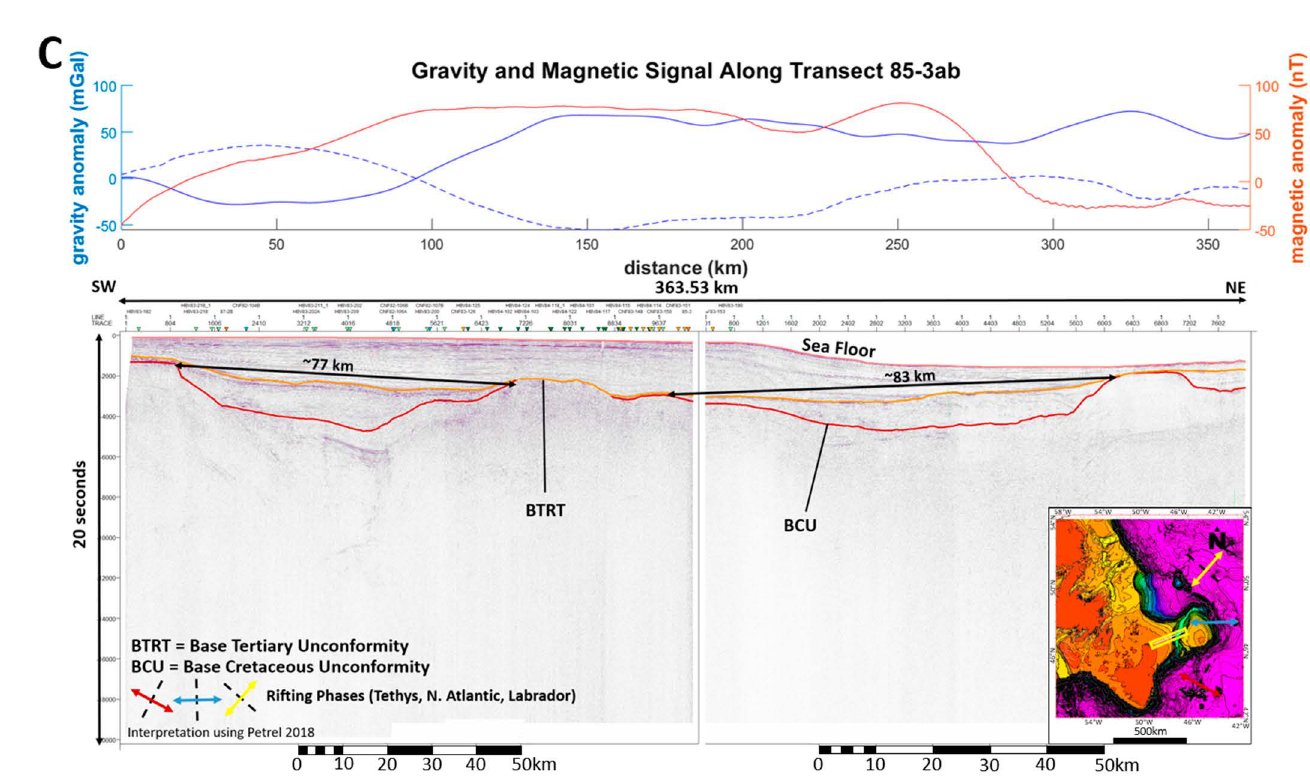
Figure 5. Interpretation of Lithoprobe line segments [54–56] and corresponding uncorrected (dashed, blue lines) and bathymetry-corrected (solid, blue lines) free air gravity, as well as magnetic anomaly (red) signatures along transects. Estimated observed boudinage wavelengths before corrections outlined in Section 3.2. Insets display location of transects within the Grand Banks region. ( A ) 87-2b, features aligned with extension related to the Tethys rifting phase (approximately 200 Ma) ( B ) 84-3b, features aligned with extension related to North Atlantic rifting phase (approximately 160 Ma) ( C ) 85-3a and -3b, features aligned with extension related to the Labrador rifting phase (approximately 120